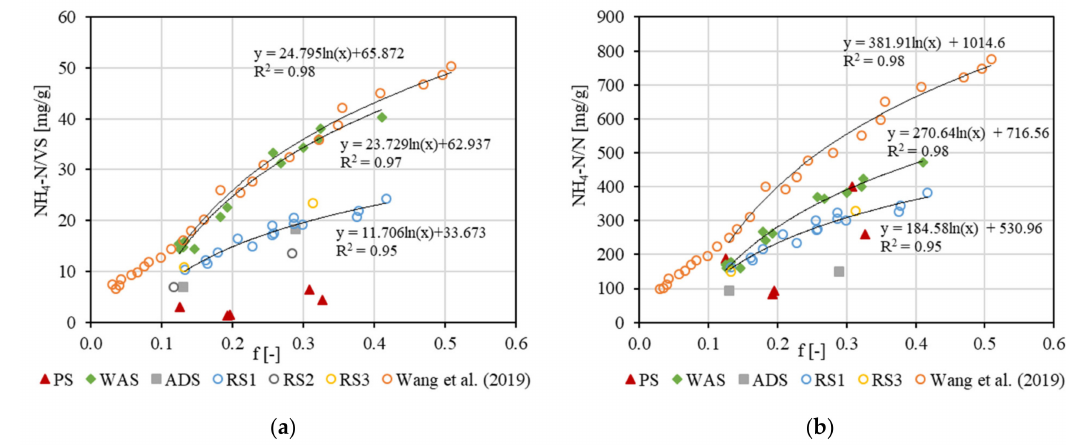
Figure 7. Curves of the ratio ( a ) NH 4 -N/VS and ( b ) NH 4 -N/N with increasing reaction intensity during hydrothermal treatment of various sewage sludges. Data adapted from Wang et al.